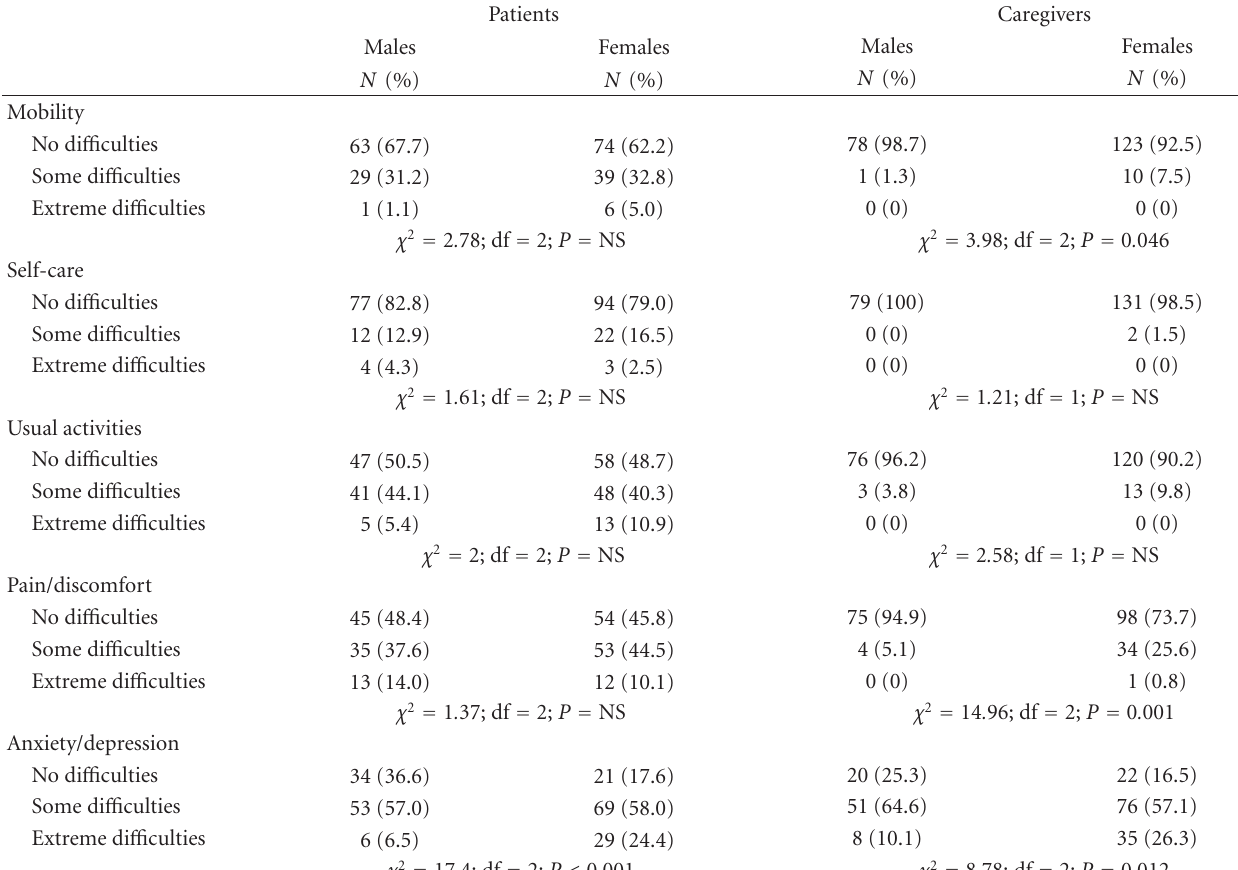
Table 4: Intragender di ff erences in patients’ and caregivers’ EQ-5D dimensions.